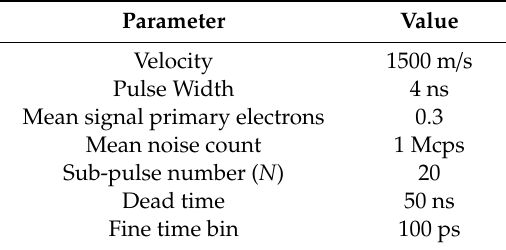
Table 1. Main parameters of the Lidar system.